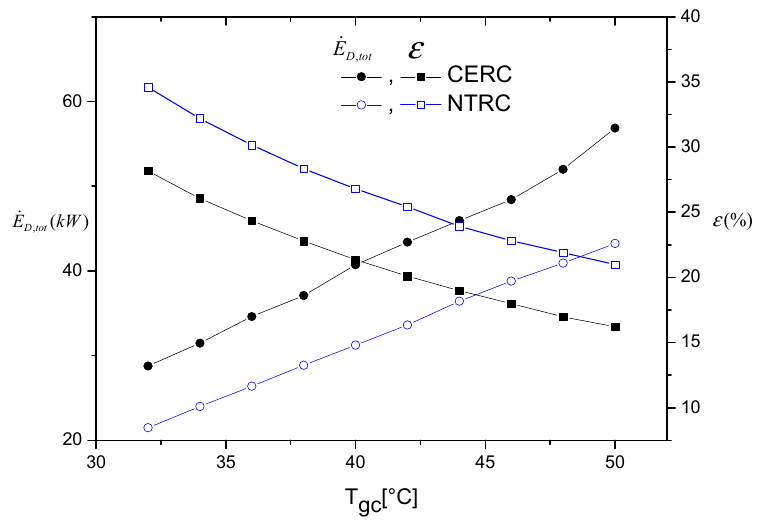
. E D , tot dependence on the exit T gc